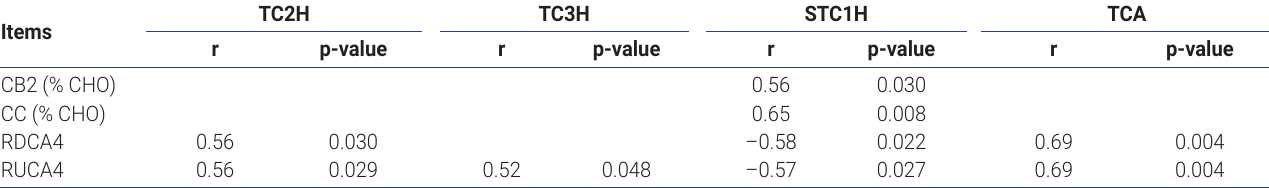
Table 4. Correlation between FTIR carbohydrate structures and the carbohydrate portions of the CNCPS system of canola seeds Items